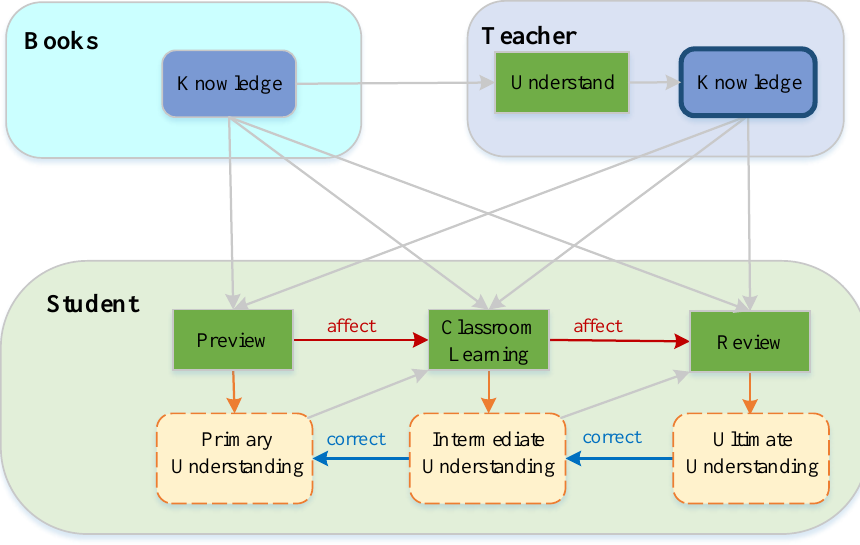
Figure 1. Illustration of the proposed